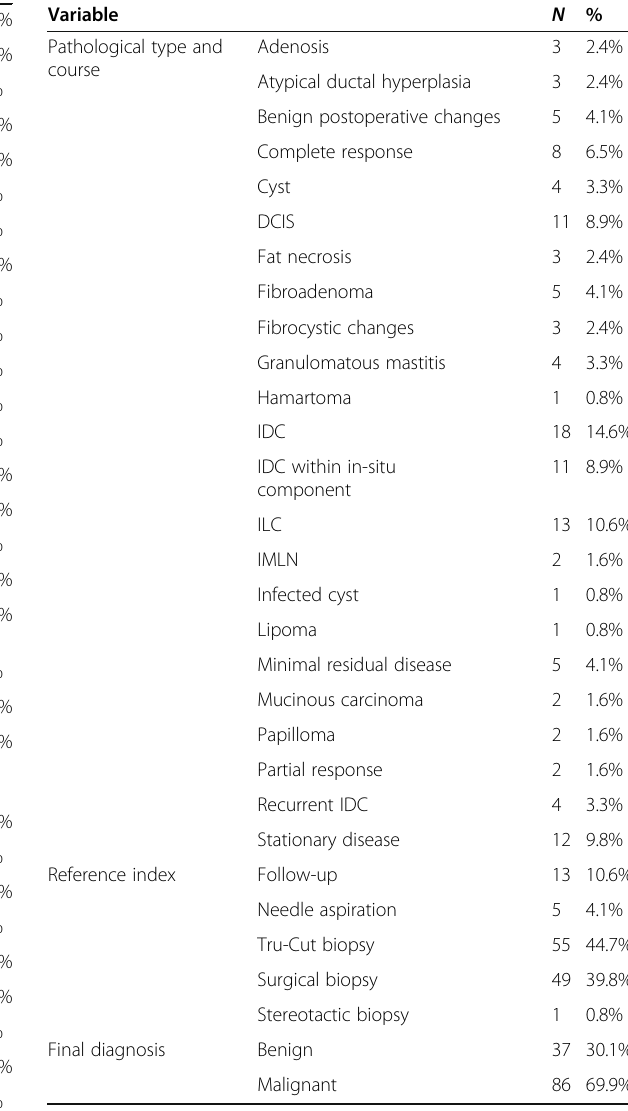
Table 2 Characteristics of the whole study population